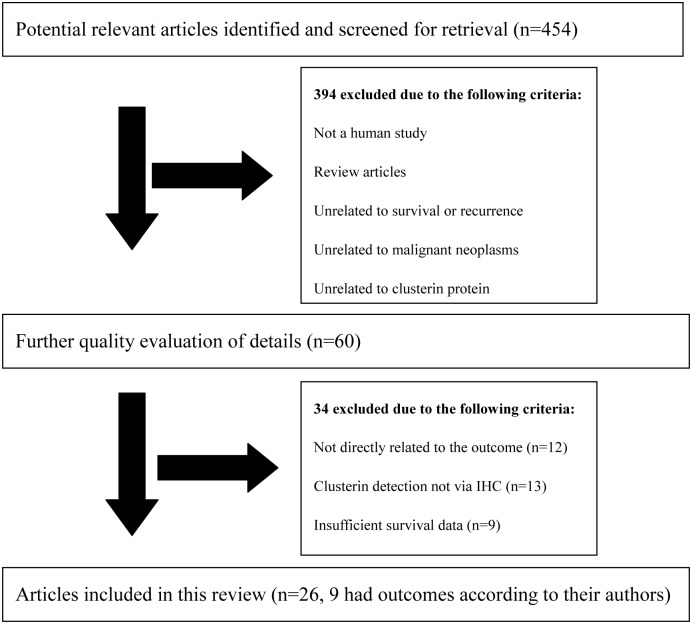
Flow diagram of the study selection process.